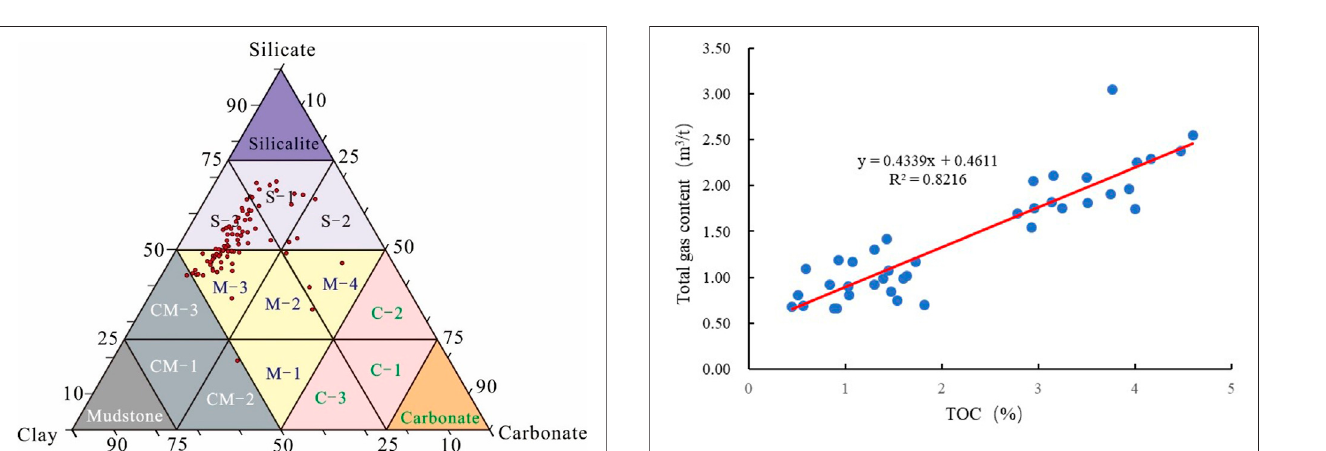
Frontiers in Earth Science |